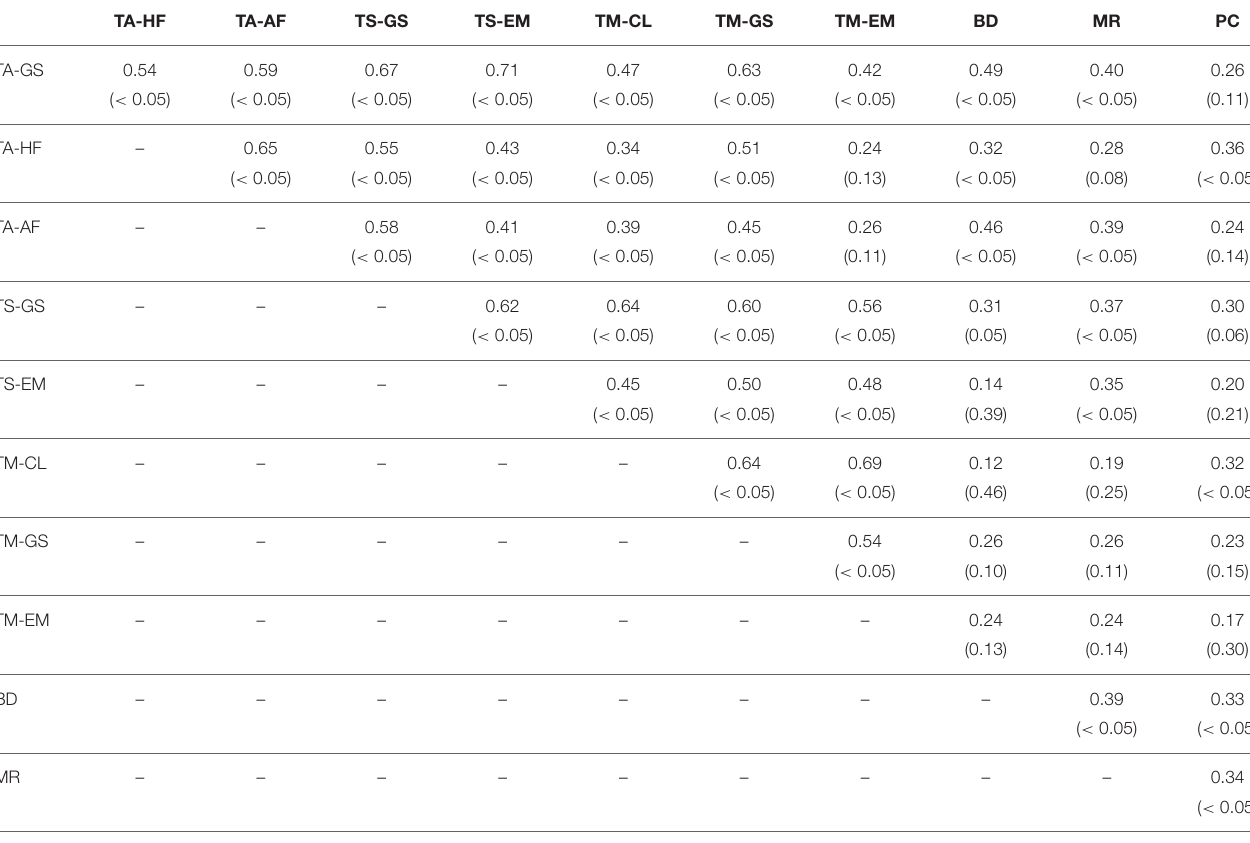
TABLE 4 | Correlation coefficients, r , among TAG-Games and WPPSI/WISC subtests. TA-HF